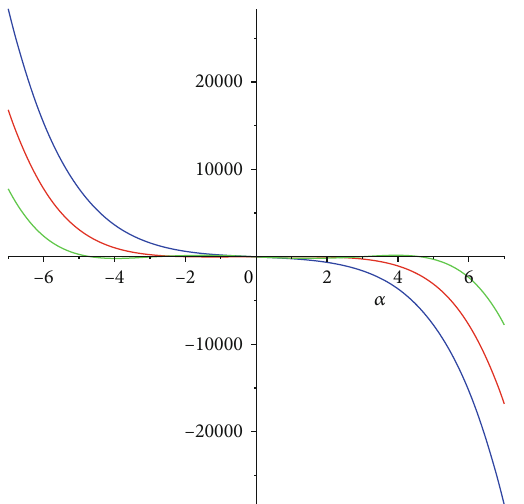
Figure 5: The behavior of stability analysis β ð α Þ and wave number α with the disparate amounts θ = − 1, θ = 0, θ = 1